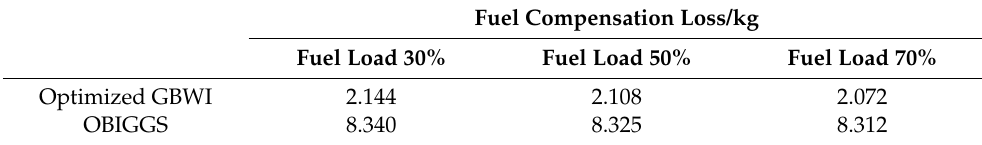
Table 1. Fuel compensatory loss in different inerting